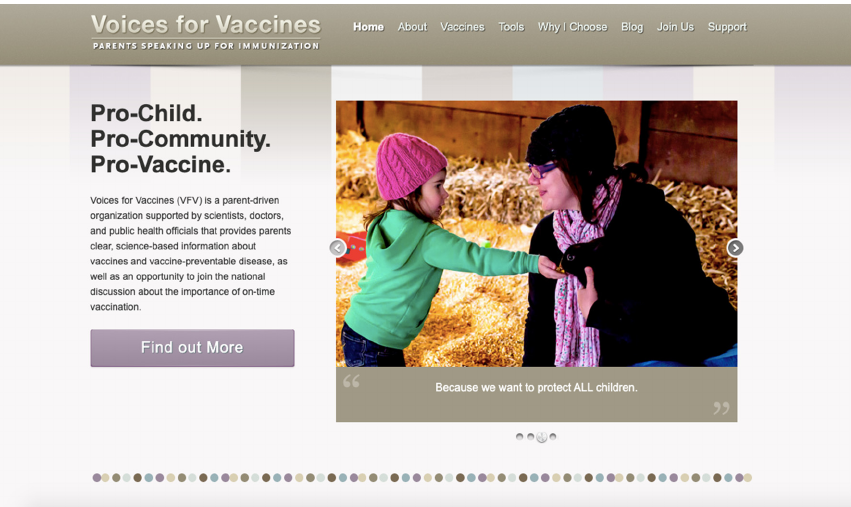
Figure 3. Voices for Vaccines’ website homepage (https://www.voicesforvaccines.org/, accessed on 2 November 2021).